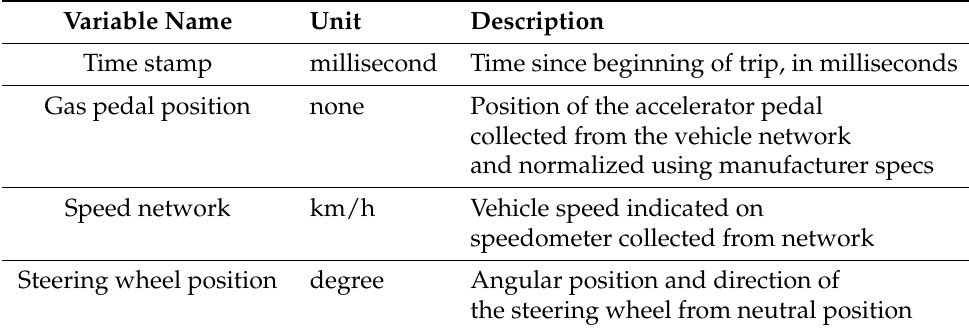
Table 1. SHRP2 data set sensor channels.